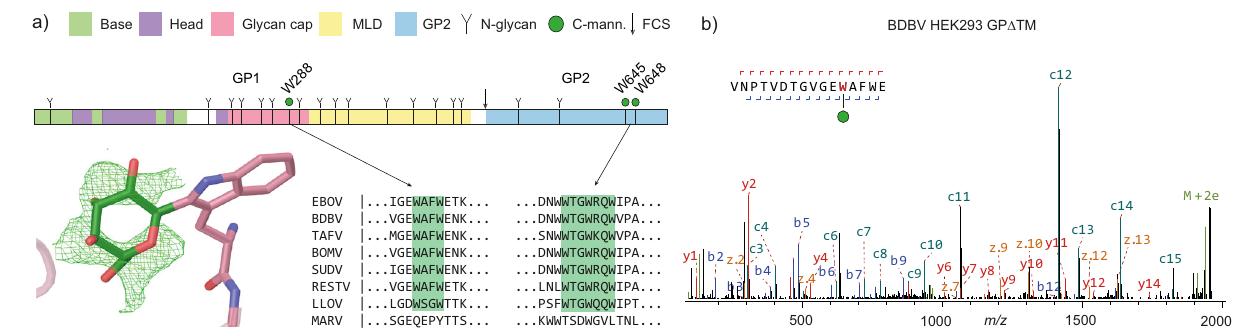
Fig. 3 C-mannosylation in ebolavirus GP. a schematic domain structure of EBOV GP with highlighted C-mannosylation sites. The modelled structure of C-mannosylated W288 was based on average F o - F c density (shown in green) of twelve isomorphic GP crystal structures. b LC-MS/MS spectrum of C-mannosylated W288 from BDBV GP Δ TM from HEK293 cells. Note the prominent c11-c12 peaks provide direct evidence for the presence and localization of the Hex ( + 162 Da) modi fi cation